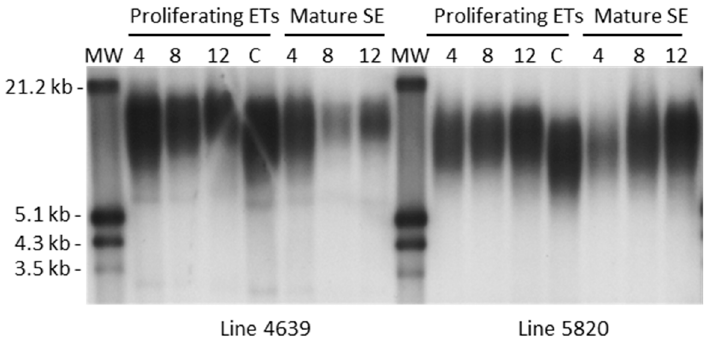
Figure 3. Southern hybridization showing telomere length in two genotypes of Norway spruce: Samples taken from proliferating embryogenic tissues (ETs) after 4, 8, or 12 months of continuous proliferation, or following cryopreservation (C) at age of 4 months, thawing, and further proliferation for 2 months prior to maturation, as well as mature somatic embryos (SE) originating in the ETs of either 4, 8, or 12 months of age are shown.